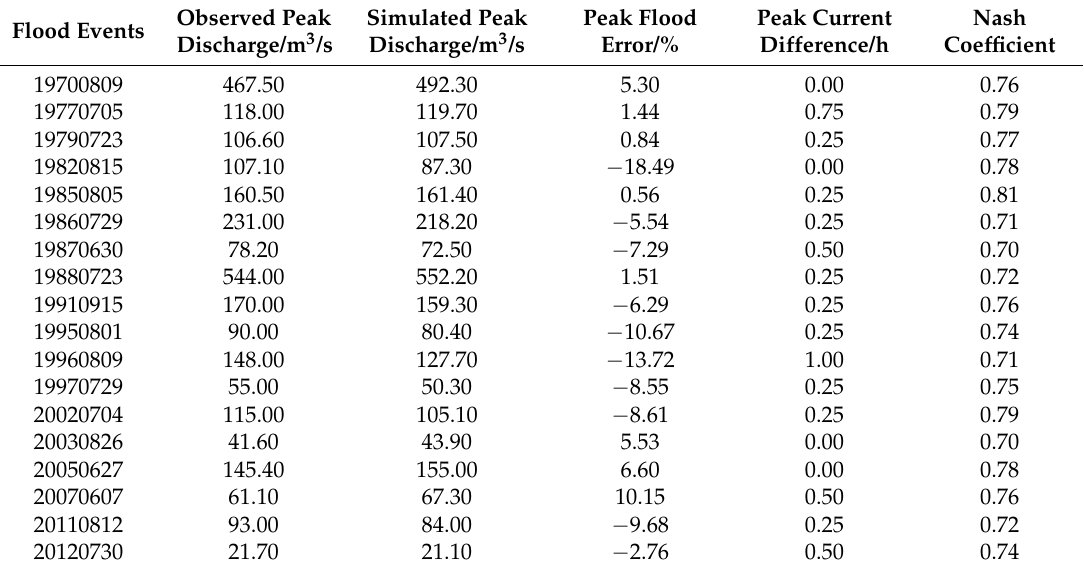
Table 8. Simulated results and evaluation criteria.